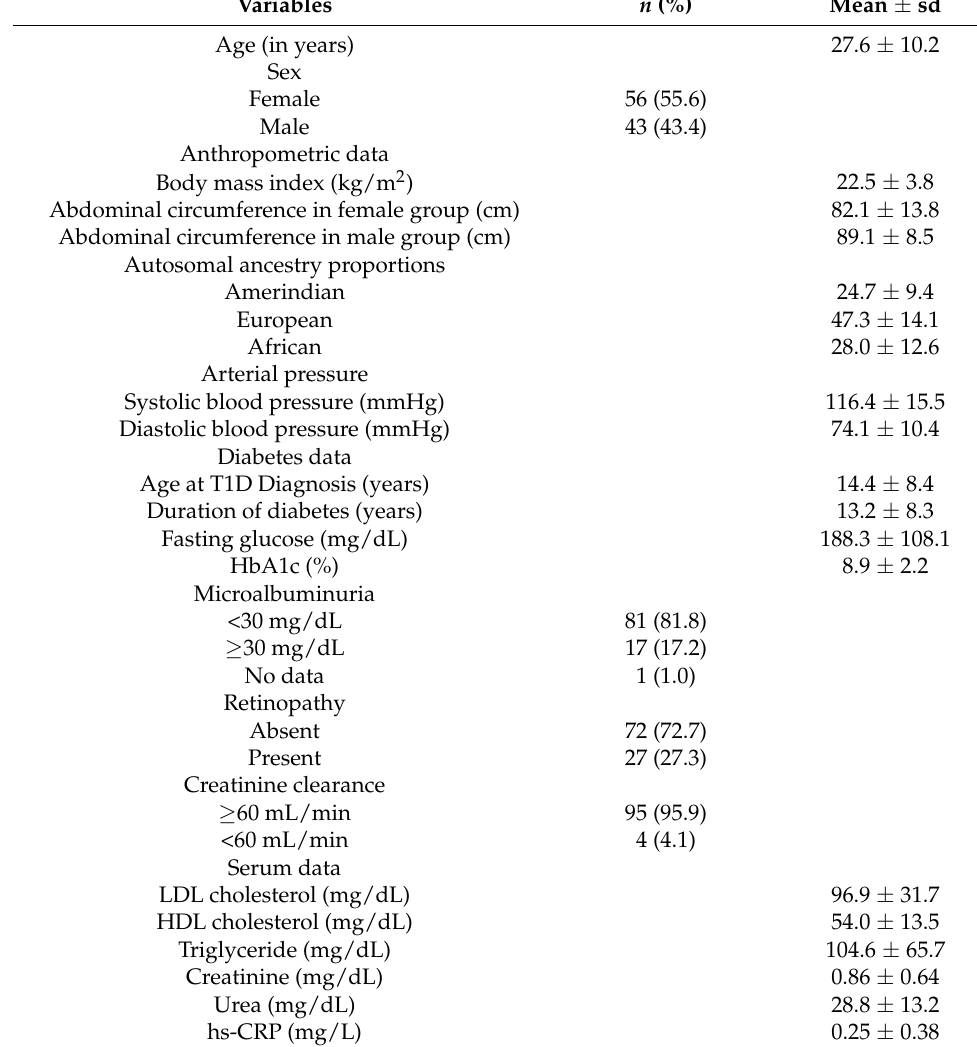
Table 1. Demographics and clinical data of type 1 diabetes